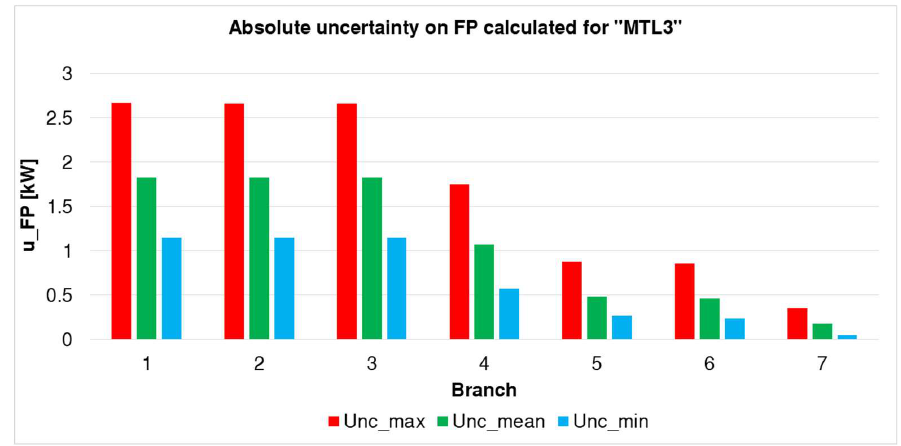
Figure 19. Maximum, average and minimum values of the absolute uncertainties in the calculated active power flows of the “MTL3” line (31 May 2018).